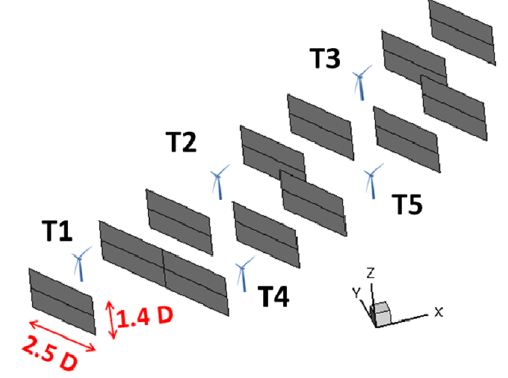
Figure 19. Example of “clipped” integration surface cutting plane. (Cutting plane is divided into equal areas, A , above/below hub height).